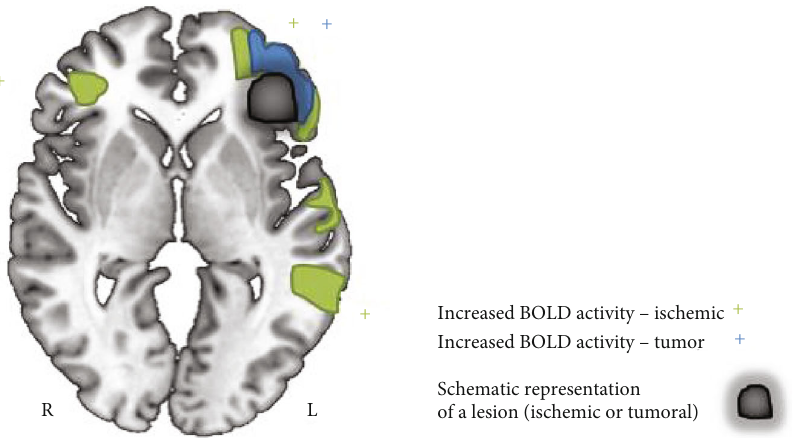
Figure 5: Schematic representation of the major mechanisms of functional reorganization of and language function in the subacute phase of a stroke lesion and postoperatively in a tumor lesion. Language fMRI activations in a stroke lesion (green color) and in a LGG (blue color) in the left inferior frontal region. Notably, perilesional activations in the left inferior frontal regions along the lesional rim are found both in stroke and in LGG, while additional compensatory activations, i.e., in the right homologue areas are more frequently observed in ischemic